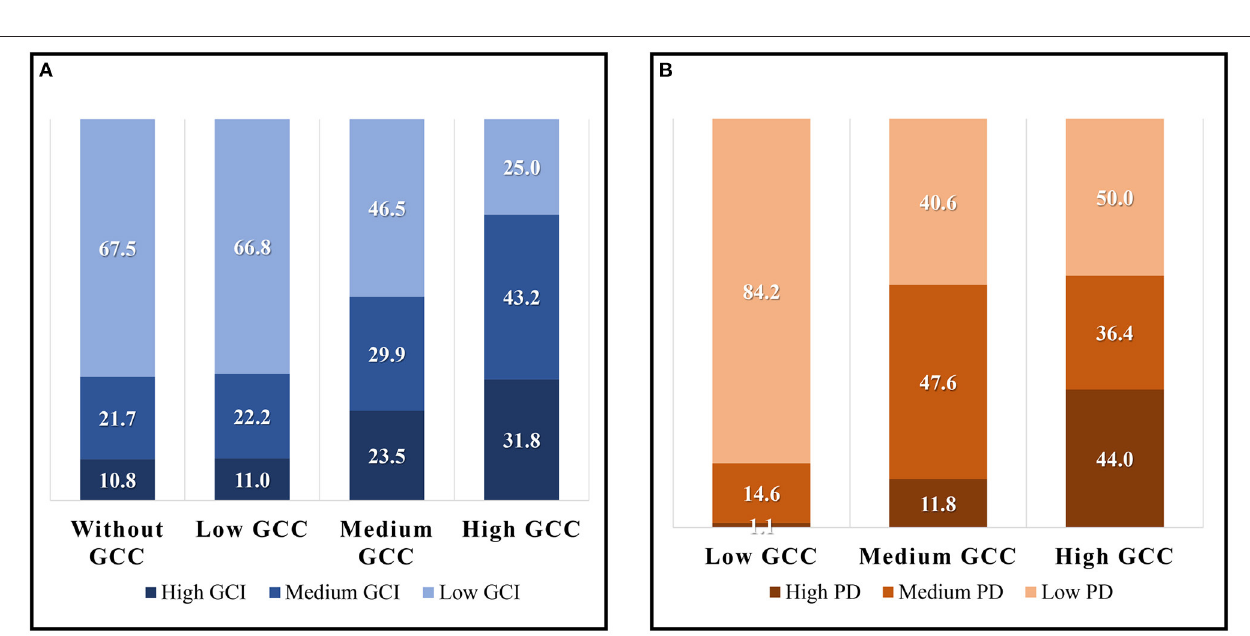
FIGURE 8 | The proportion of green space with low, medium, and high GCI in different GCC groups (A) , the proportion of green space serving low, middle, and high population density in different GCC groups (B) .